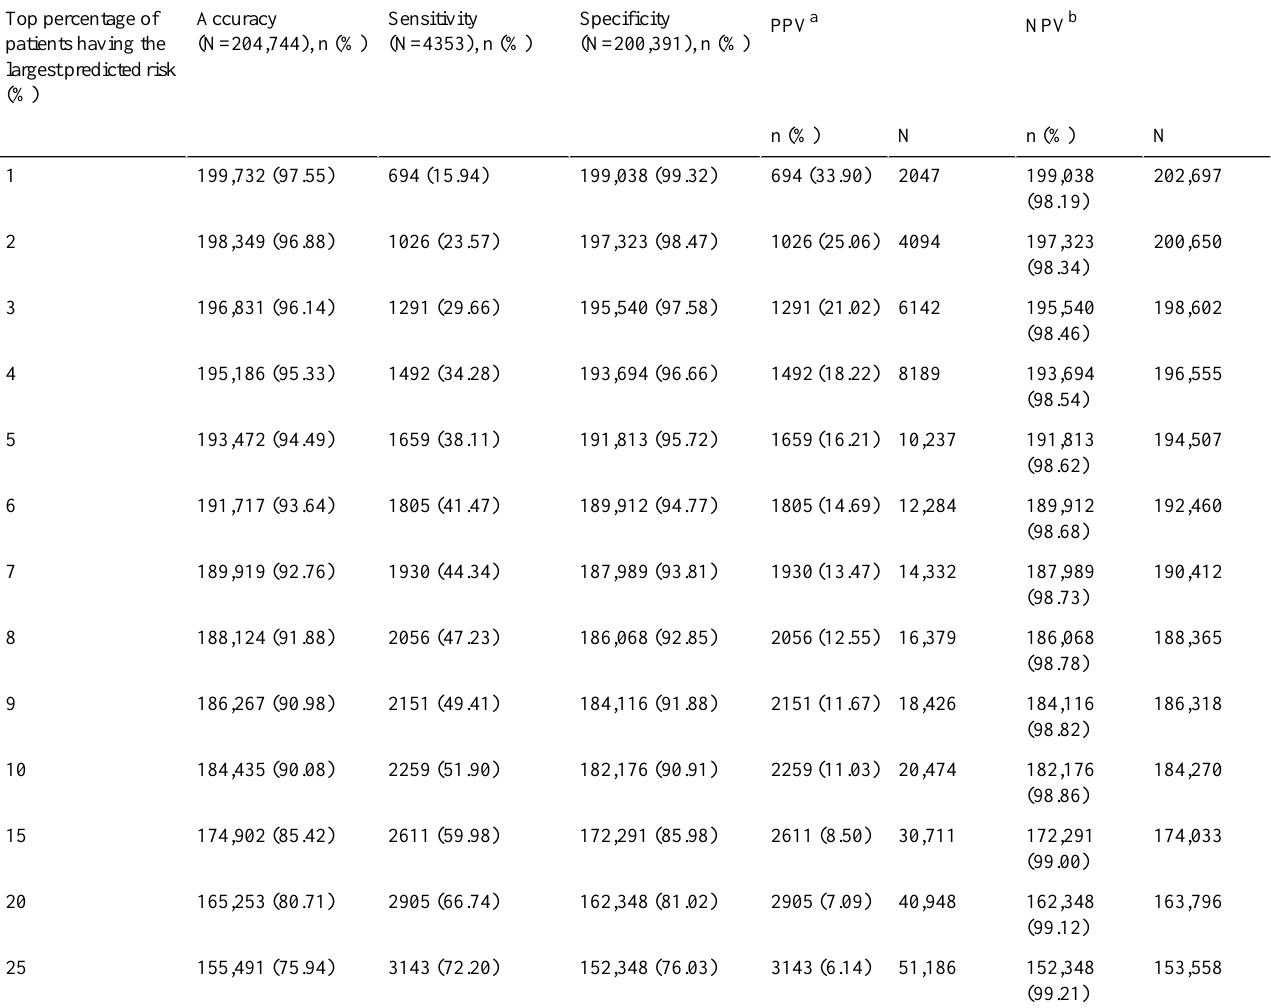
Table 3. The performance measures of our final predictive model when various top percentages of patients having the largest predicted risk were adopted as the cutoff point for doing binary classification.